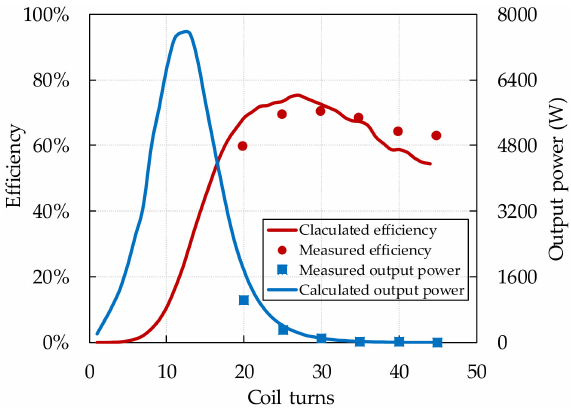
Figure 8. Relationship between coil turns and system performance with fixed inner